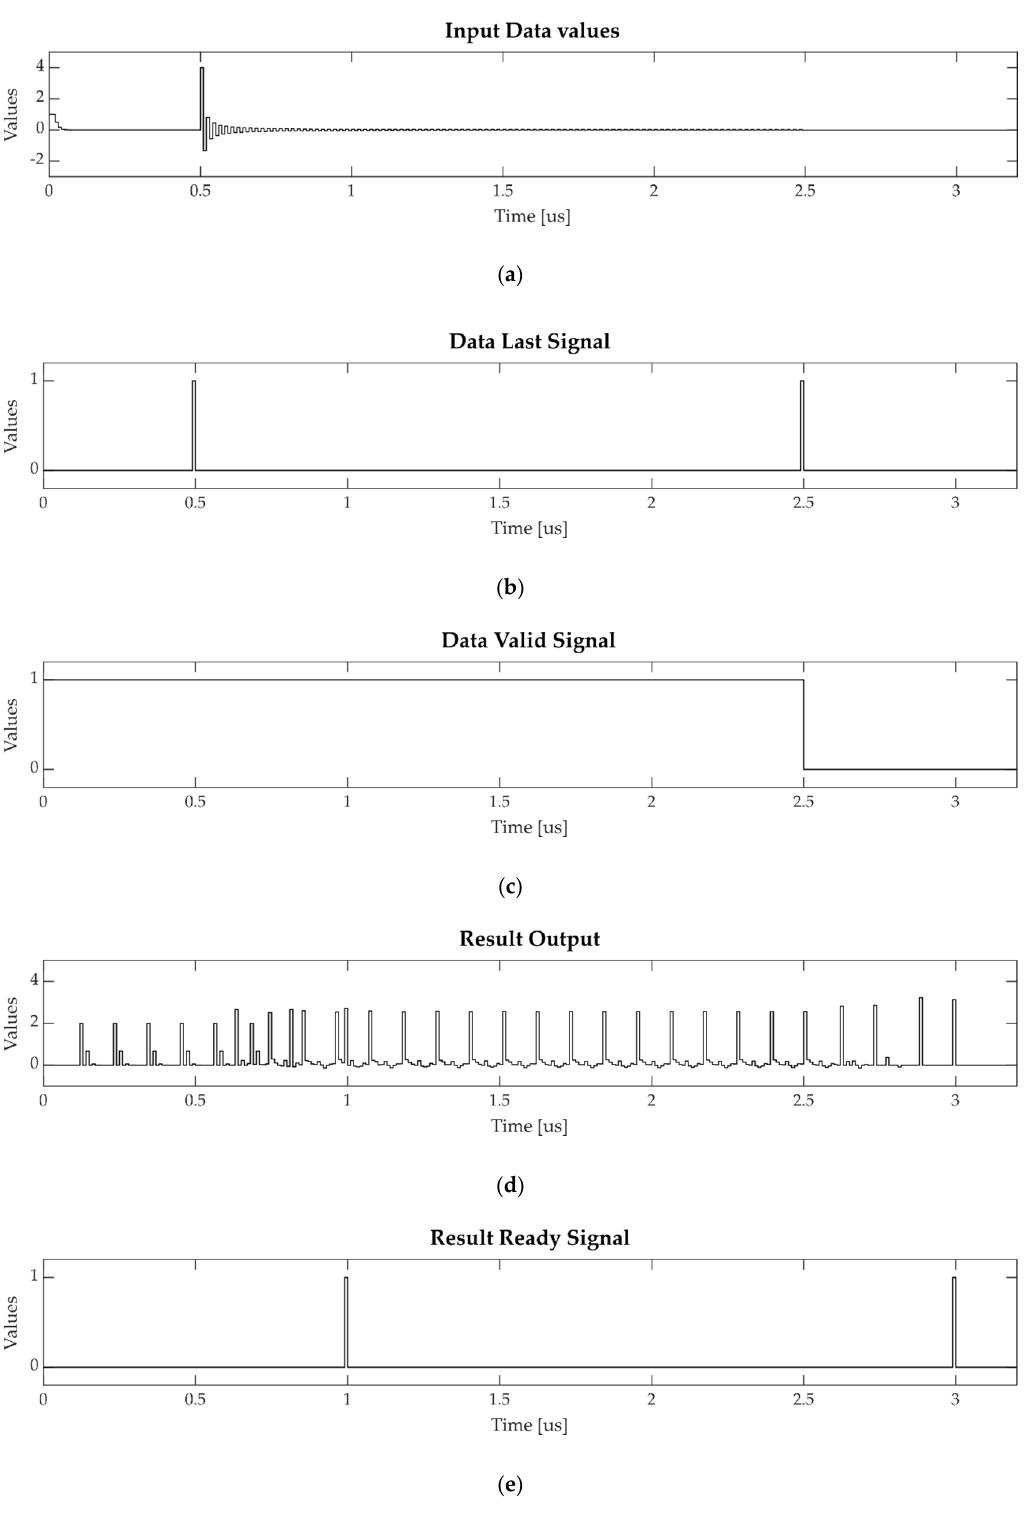
Figure 4. Input and output signals of the multi-set DB accumulator in Simulink simulation: ( a ) Input vector values, ( b ) Data_last signal, ( c ) Data_valid signal, ( d ) Accumulator output value, and ( e ) Result_ready signal.